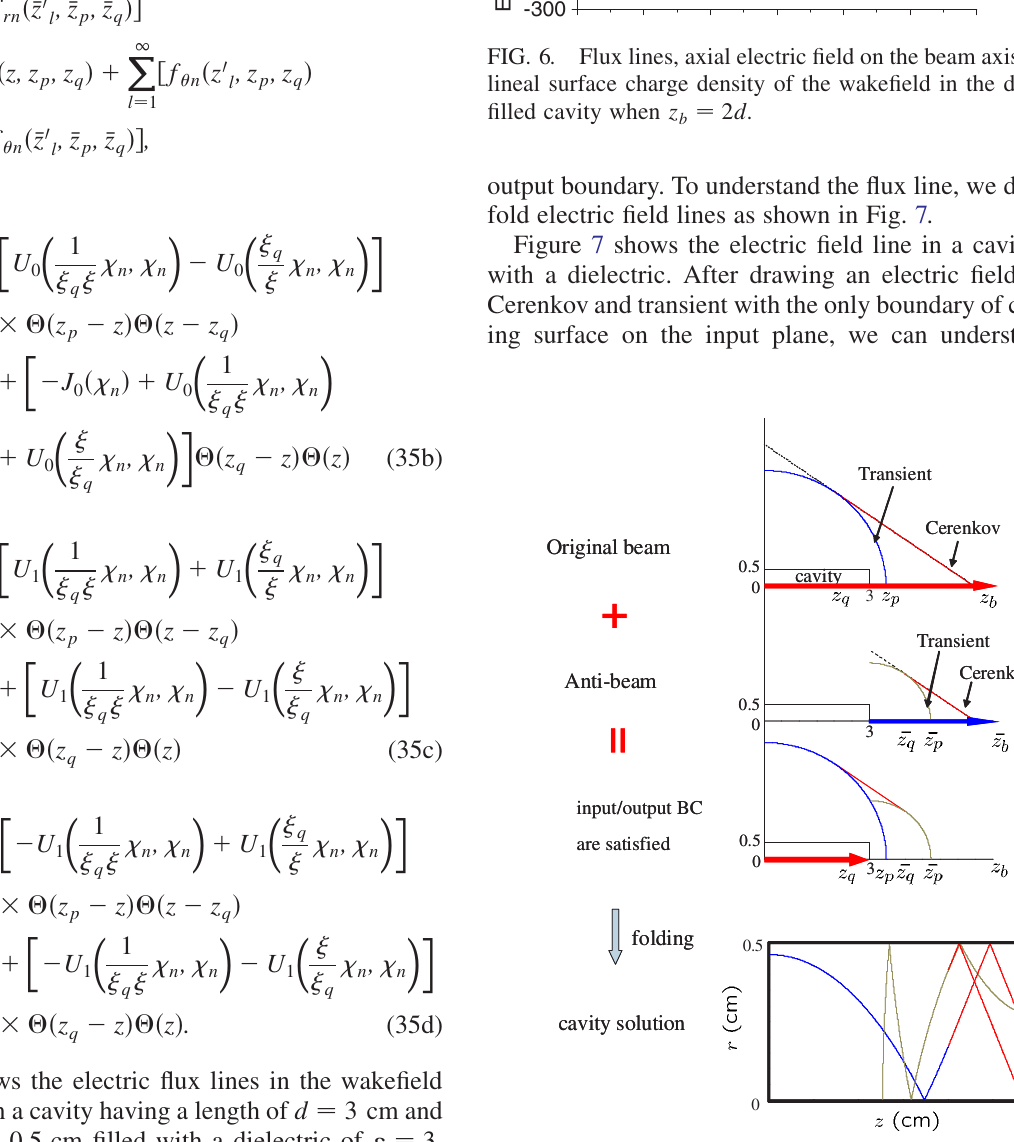
FIG. 7. (Color) Electric field lines in a cavity: Folding Cerenkov and transient line from the original charge and anticharge, we can draw the electric field line in a